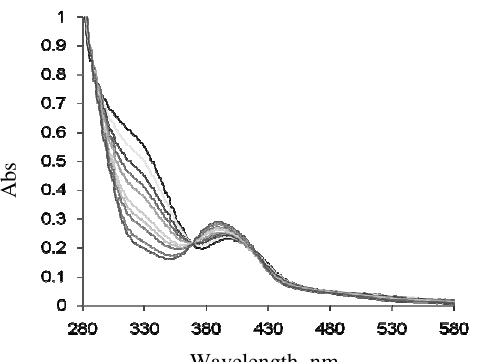
Figure 2. Variation of electronic spectra of [Co(Salen)(PPh CH CN at 25 °C in 280 to 580 nm region for number of titration correspondent to 10 series 3